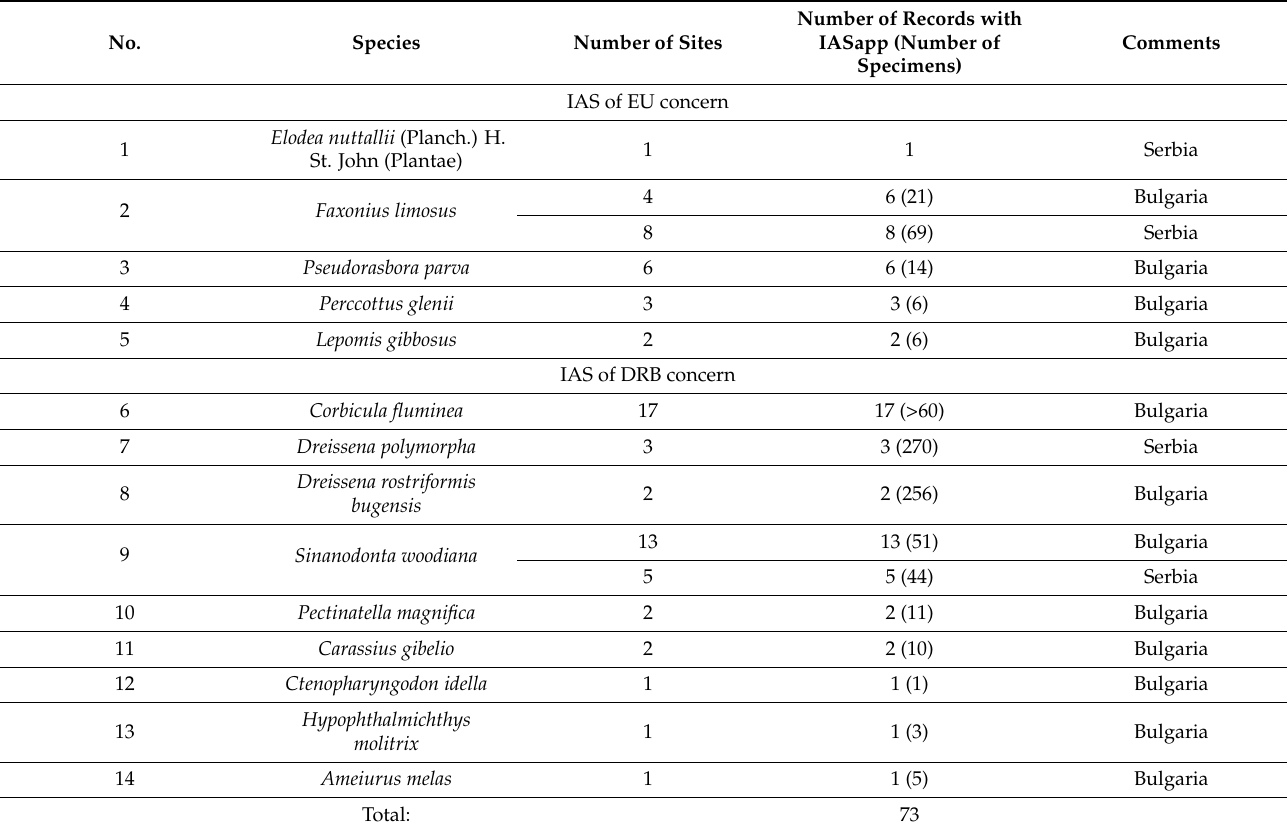
Table 3. Invasive alien species of EU and Danube River Basin (DRB) concern recorded with IASapp in the Lower Danube Region during JDS4 in